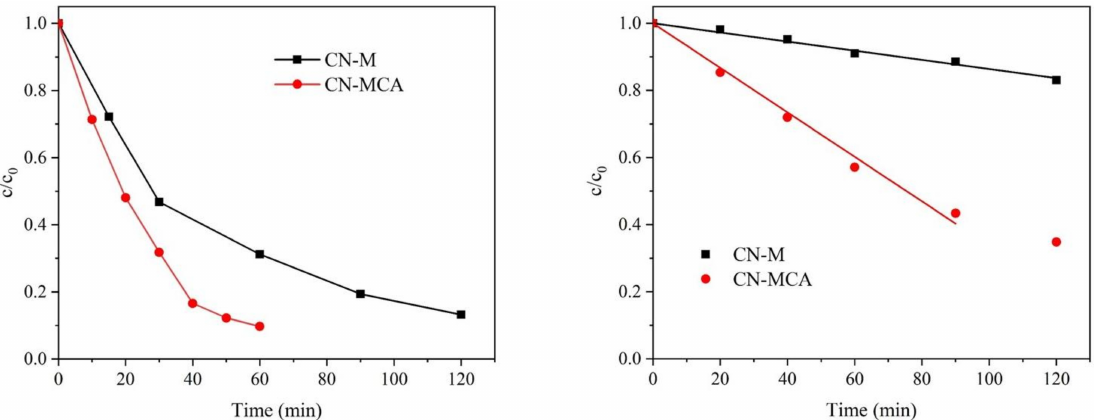
Figure 5. Photocatalytic decomposition of ofloxacin ( left ) and ampicillin ( right ) depending on time.